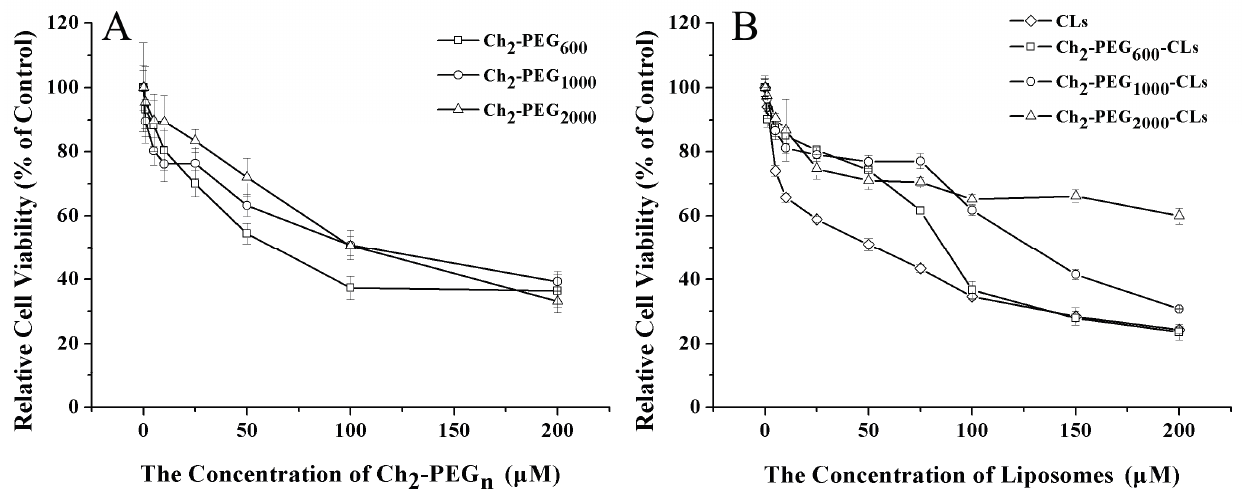
Figure 7. Cytotoxicity of Ch 2 -PEG n and Ch 2 -PEG n -CLs on SKOV-3 cells by the MTT assay (Mean ± SD, n = 4–6). ( A ) IC 50 values for Ch 2 -PEG 600 , Ch 2 -PEG 1000 and Ch 2 -PEG 2000 were about 78, 145 and 127 μ M, respectively; ( B ) IC 50 values for CLs, Ch 2 -PEG 600